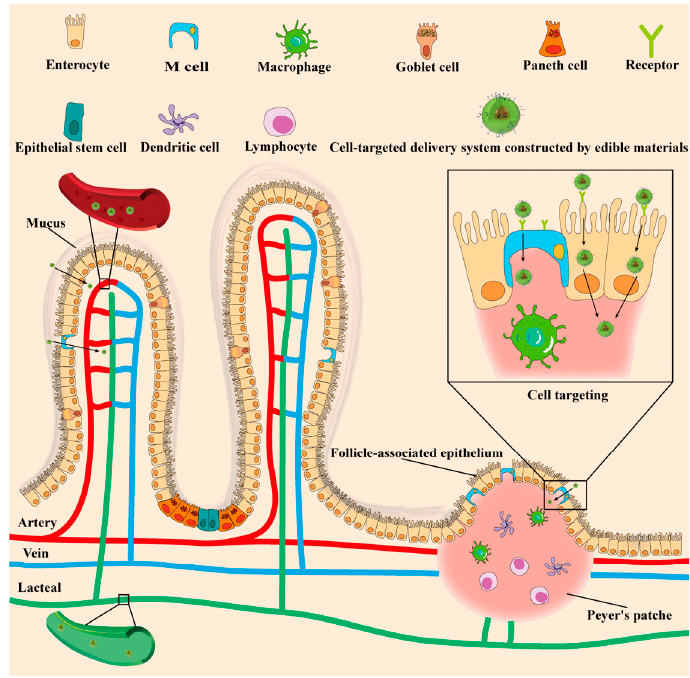
Figure 2. The physiological structure of the intestinal tract and schematic diagram of cell targeting. Adapted with permission from Ref. [30]. Copyright 2018, American Chemical Society.